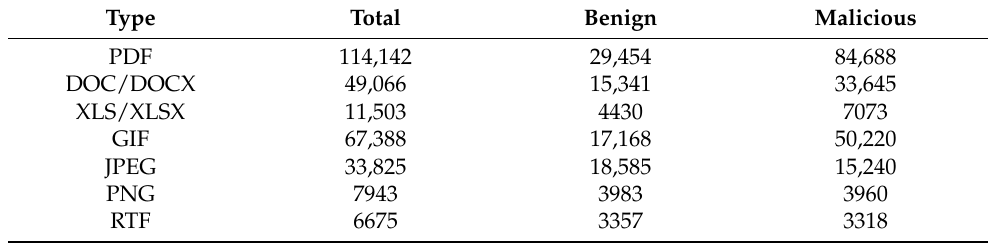
Table 4. The distribution of